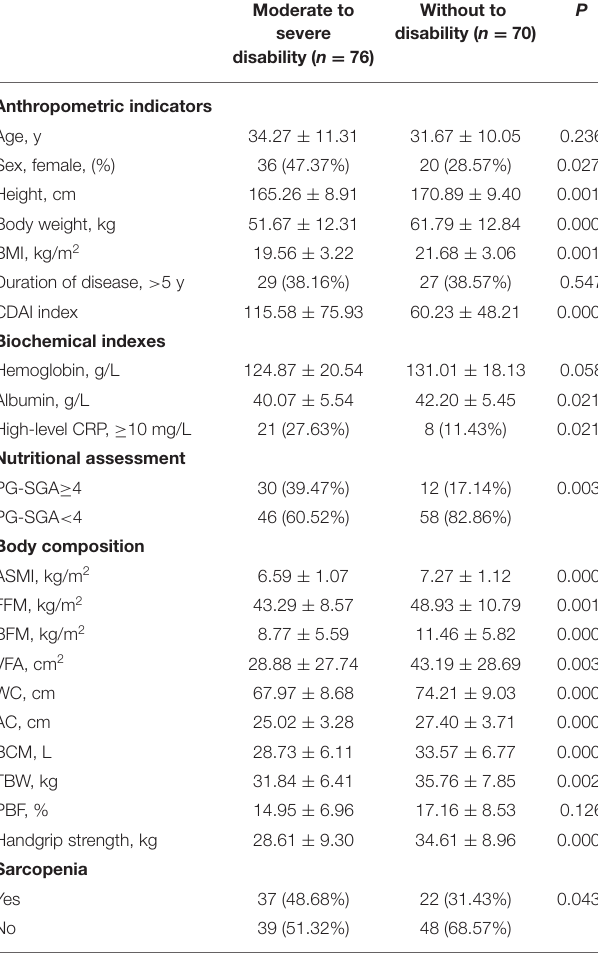
TABLE 4 | Risk factors associated with moderate to severe disability for all CD patients. Variables Univariate analysis Multivariate